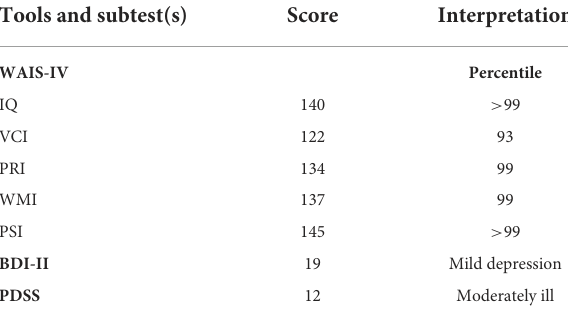
TABLE 1 Initial assessment